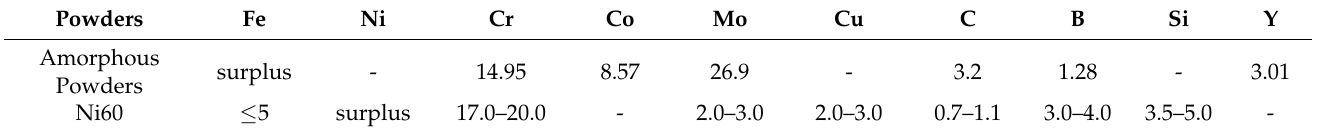
Table 1. Chemical compositions of the feedstock powders in HVOF (mass fraction/%).